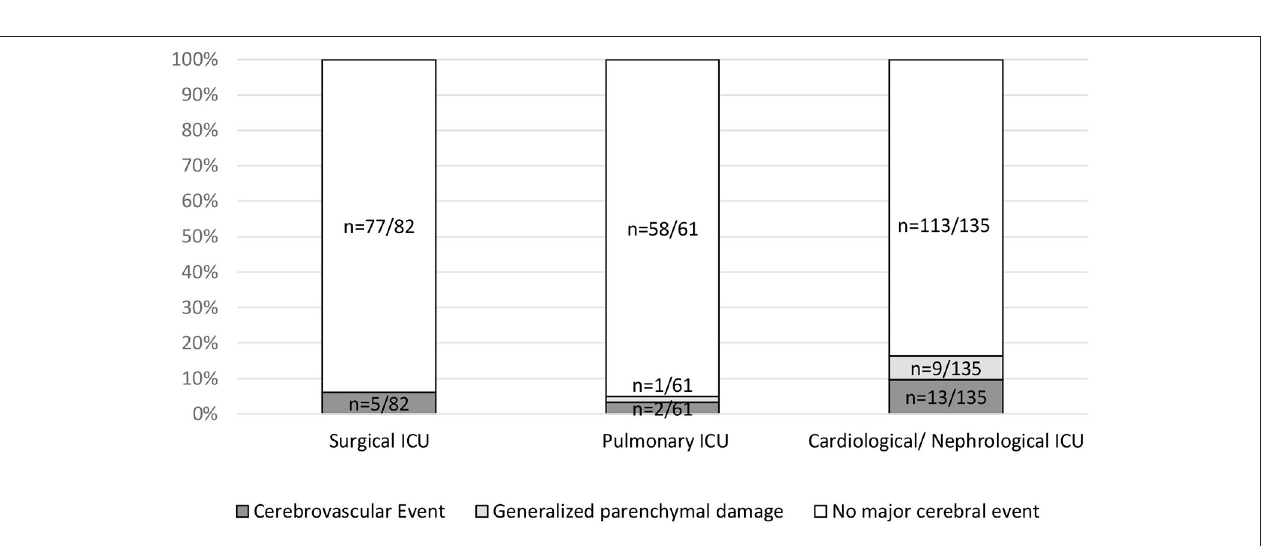
(81.5% as compared with 18.5% in patients with GCS > 9) was confirmed with p <